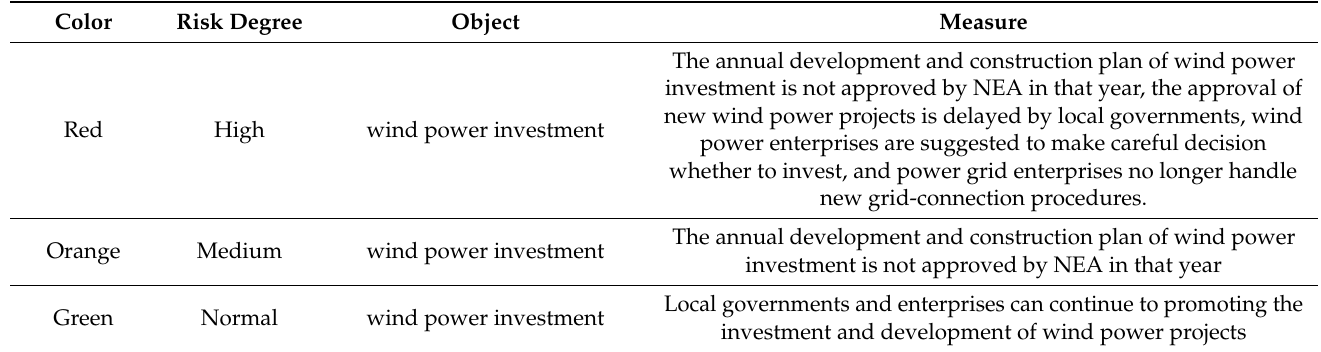
Table 7. Wind power investment supervising and warning